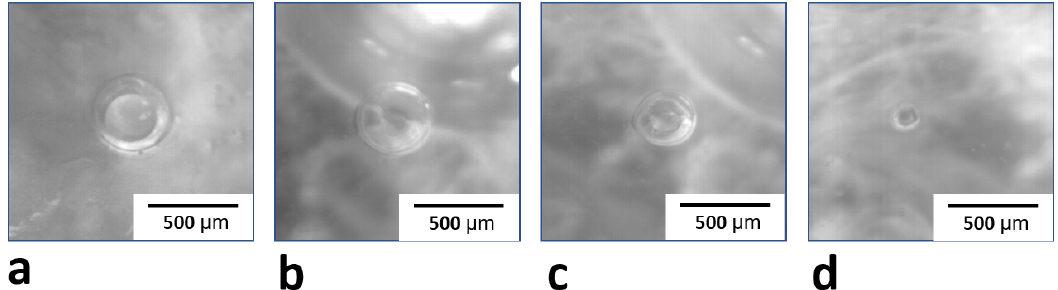
Figure 2. Dissolution of the synthetic silica ‘ particles in the experimental slag where the images were taken at, ( a ) time zero, ( b ) 20 s of dissolution, ( c ) 40 s of dissolution, and ( d ) 60 s of dissolu- tion.